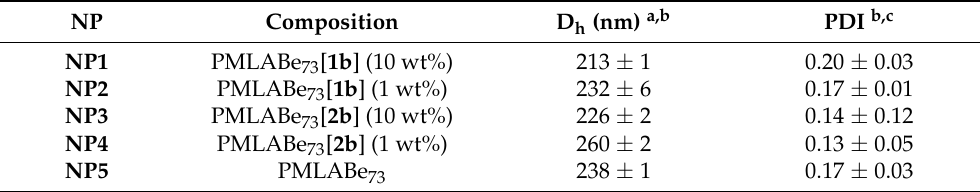
Table 1. Composition, hydrodynamic diameter (D h ) and polydispersity (PDI) of porphyrin-loaded and empty NPs.